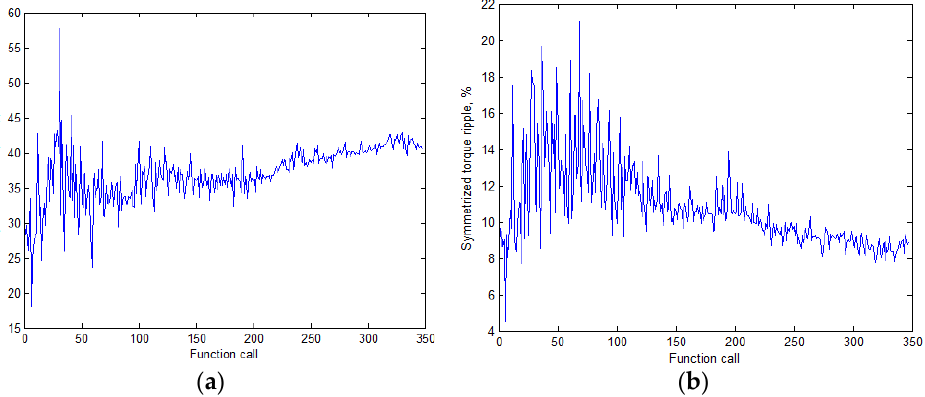
Figure 10. Change of the generator parameters during optimization: ( a ) Nonsymmetrized torque ripple; ( b ) Symmetrized (output) torque ripple.